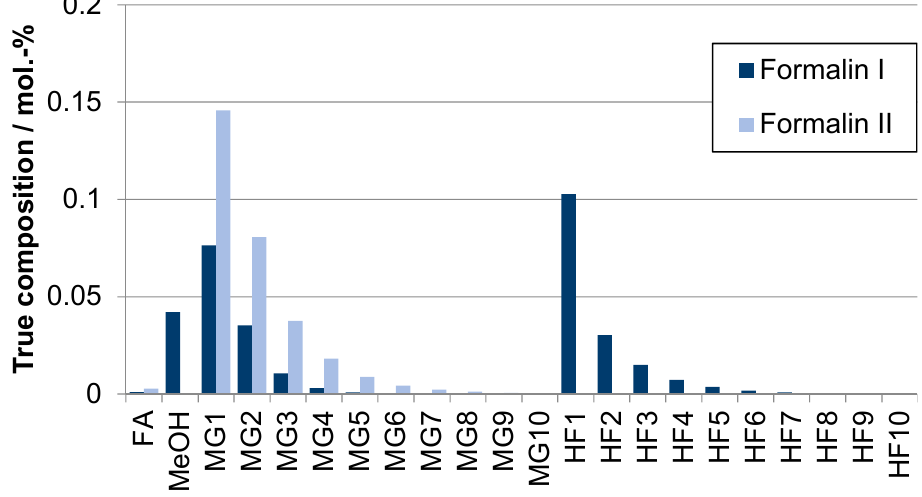
Figure 13. True composition in molar percent of formalin I and formalin II at 60 °C and 1 bar.